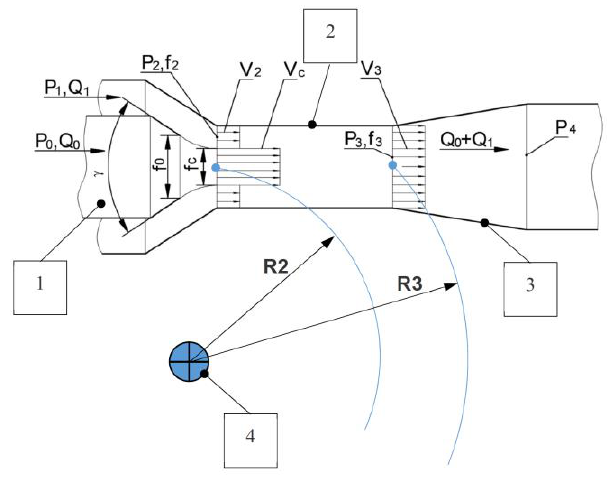
Figure 6. Computational scheme of the jet apparatus. Source: authors’ development.